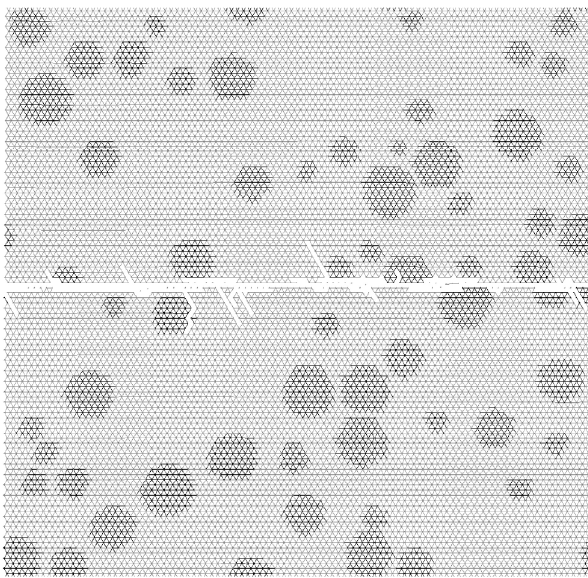
Fig. 16 Subsurface fracture on Y-TZP-20%Al 2 O 3 at dilatancy coefficient  =